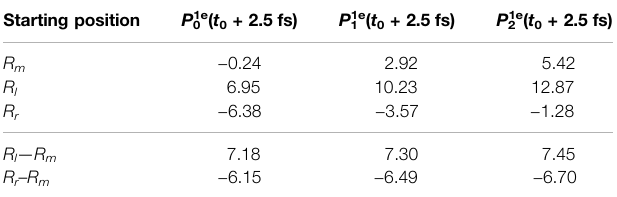
TABLE 1 | Nuclear momentum expectation value of the different nuclear wave packets on different parent ion states, see Eq. 26 , for the three different initial nuclearpositions( fi rsttothirdrow).Thefourthand fi fthrowsshowthedifferenceof non-equilibrium toequilibrium momentum, emphasising momentum conservation upon ionisation. Starting